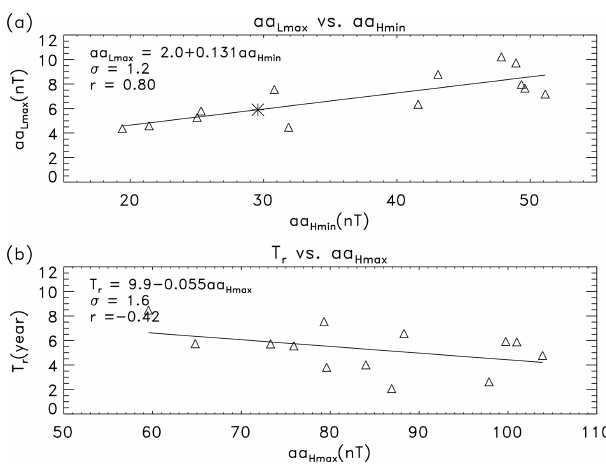
Figure 4. Scatter plots of aa L aa H (b) . max